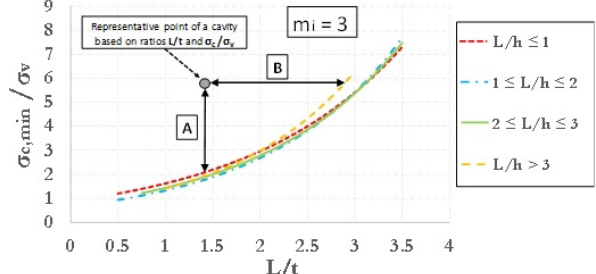
Figure 2. Curves of σ c , min /σ v against L/t for different values of the ratio L/h ( m i = 3) (modified after Perrotti et al., 2018).